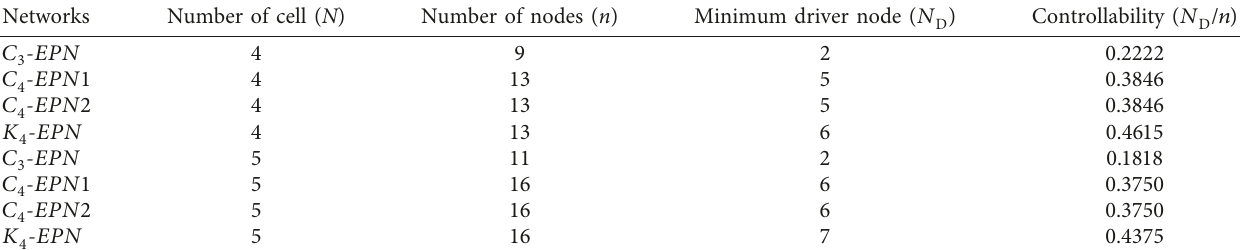
- EPN , C - EPN , and K 3 4